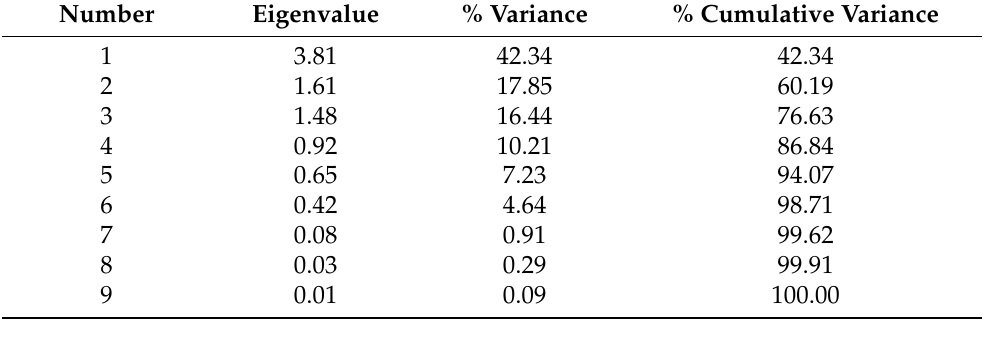
Table 6. Eigenvalue and percentage of data explained by each factor.